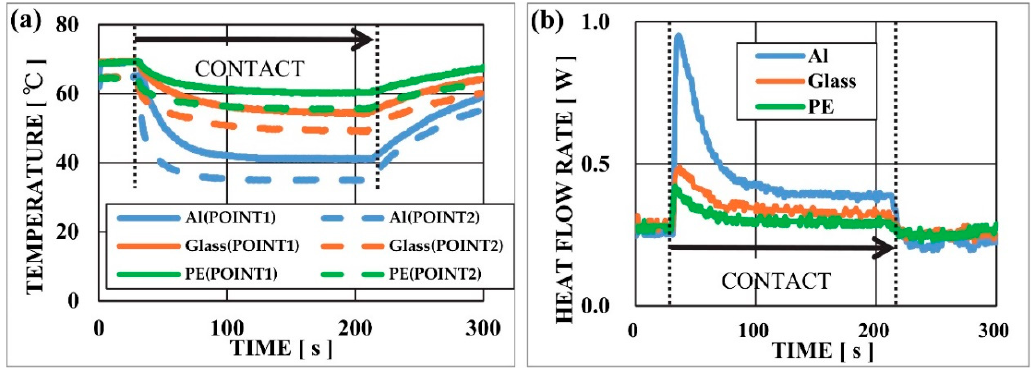
Figure 7. ( a ) Temperature changes during heat flow measurement; ( b ) Heat flow rate changes during heat flow